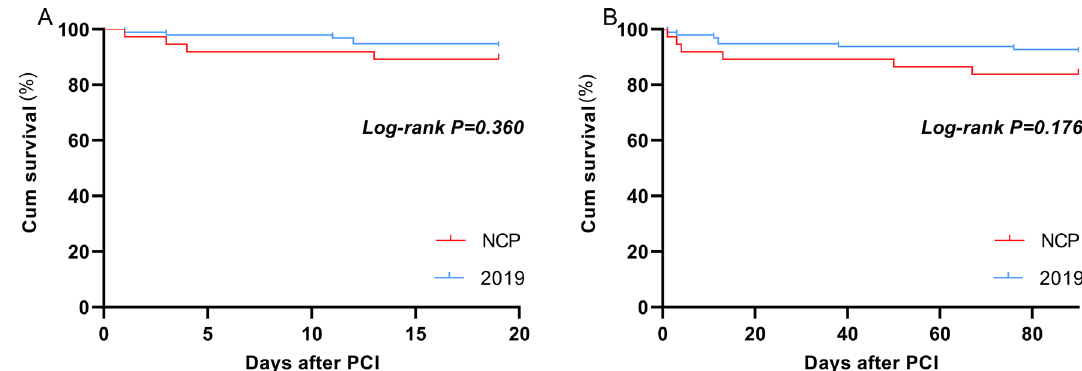
Figure 5. Kaplan–Meier curves for death in hospital ( A ) and 3-month follow-up ( B ) of AMI patients undergoing PCI in 2020 coronavirus disease (COVID-19) pandemic period and